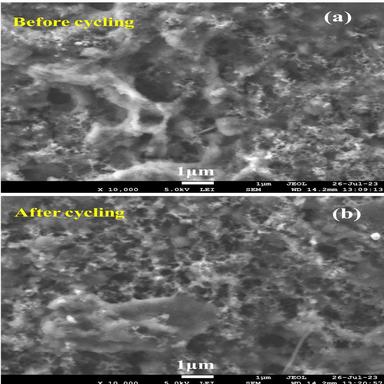
SEM images of the PDI-NDI-PDI/GF electrode (a) before 10,000 GCD cycles and (b) after 10,000 GCD cycles.